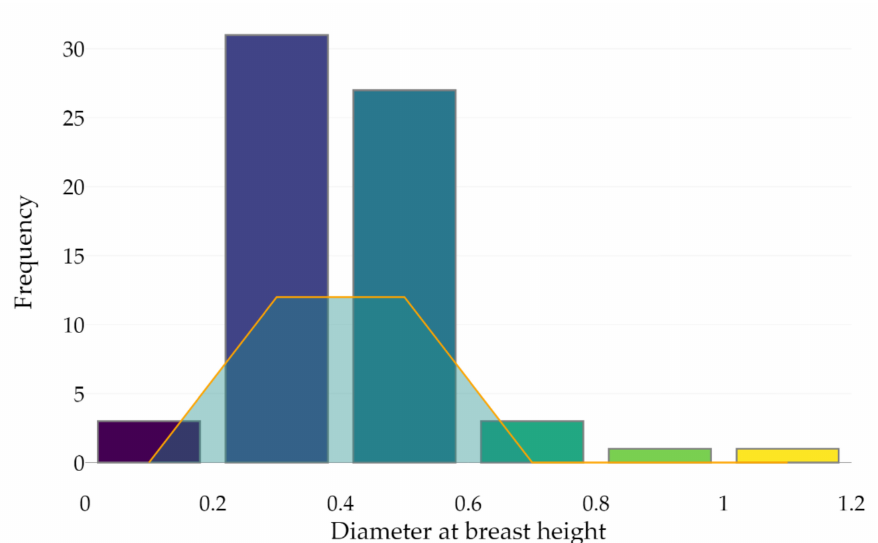
Figure 9. Tree stem classification according to the DBH estimation (bins of 0.2 m) from the point cloud acquired during the leaf-off season using a 75 ◦ MSAR. The orange line indicates the number of correctly classified tree stems per